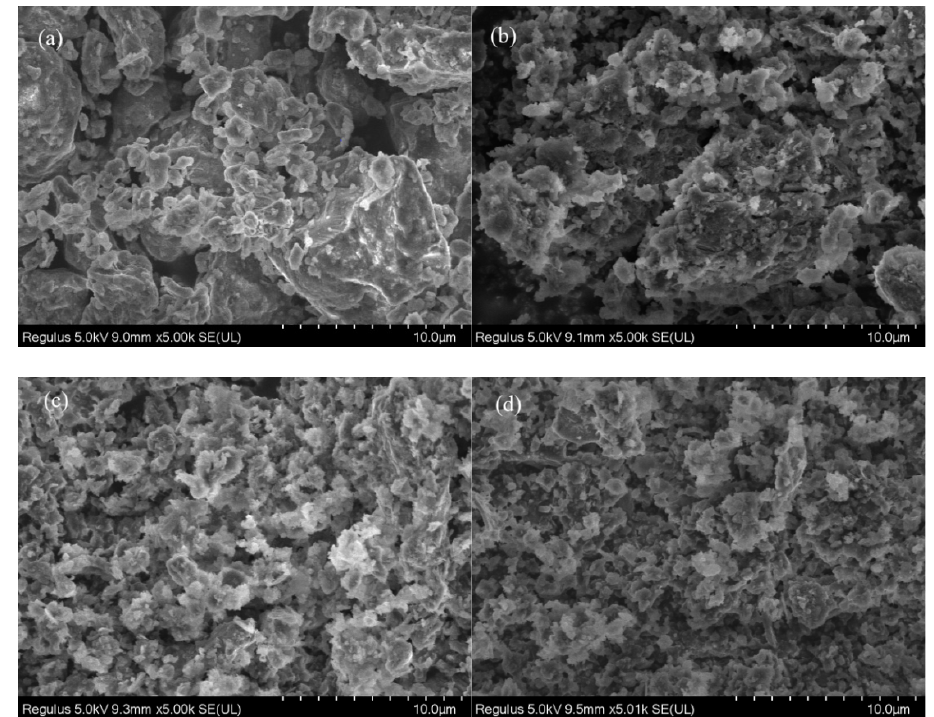
Figure 3. SEM image of dry sewage sludge ( a ), SSHC ( b ), AHC0.1 ( c ), and AHC0.5 ( d ).